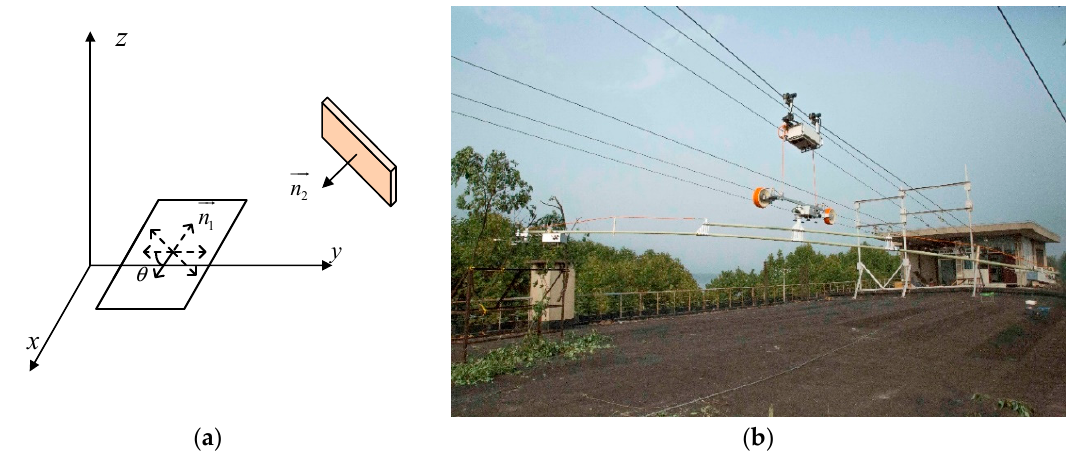
Figure 11. Received Signal Strength (RSS) prediction experiment. ( a ) Illustration of experiment; ( b ) photographs of the testing site.